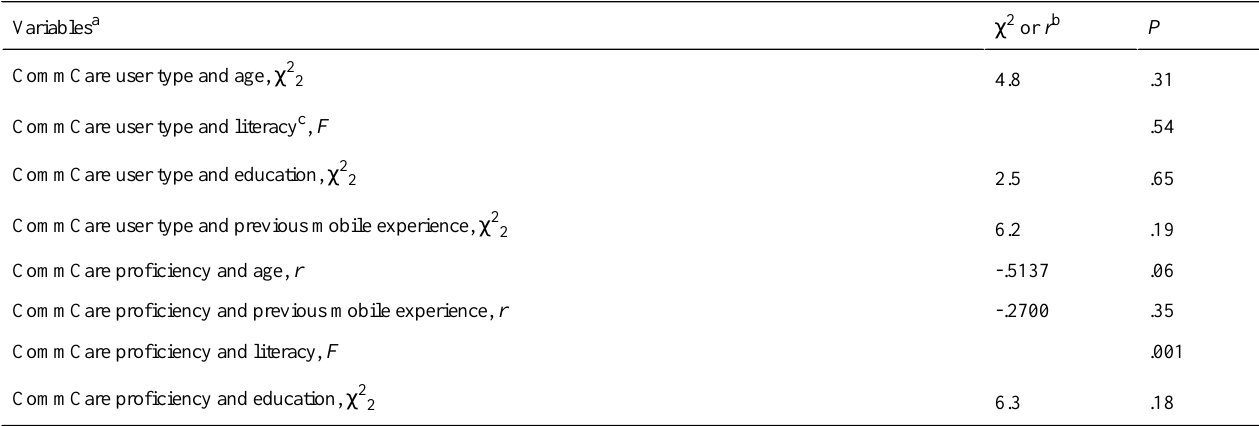
Table 8. Correlations between CommCare adoption and ASHA characteristics.